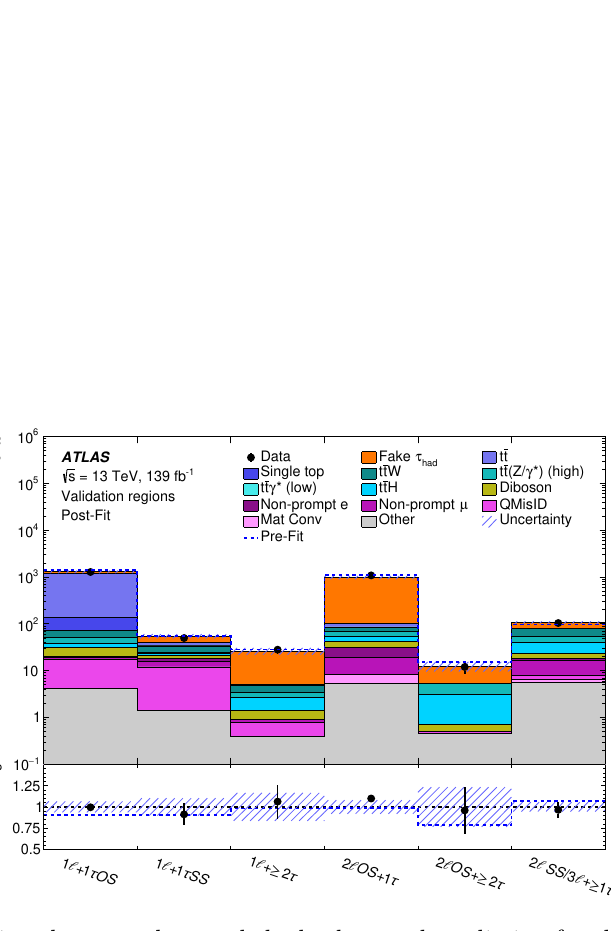
Figure 11. Comparison between data and the background prediction for the event yields in the six validation region categories. The background contributions after the likelihood fit to data (“Post-Fit”) under the background-only hypothesis are shown as filled histograms. The ratio of the data to the background (“Bkg”) prediction is shown in the lower panel. The total background prediction before the likelihood fit to data (“Pre-Fit”) is shown as a dashed blue histogram (line) in the upper (lower) panel. The size of the combined statistical and systematic uncertainty in the background prediction is indicated by the blue hatched